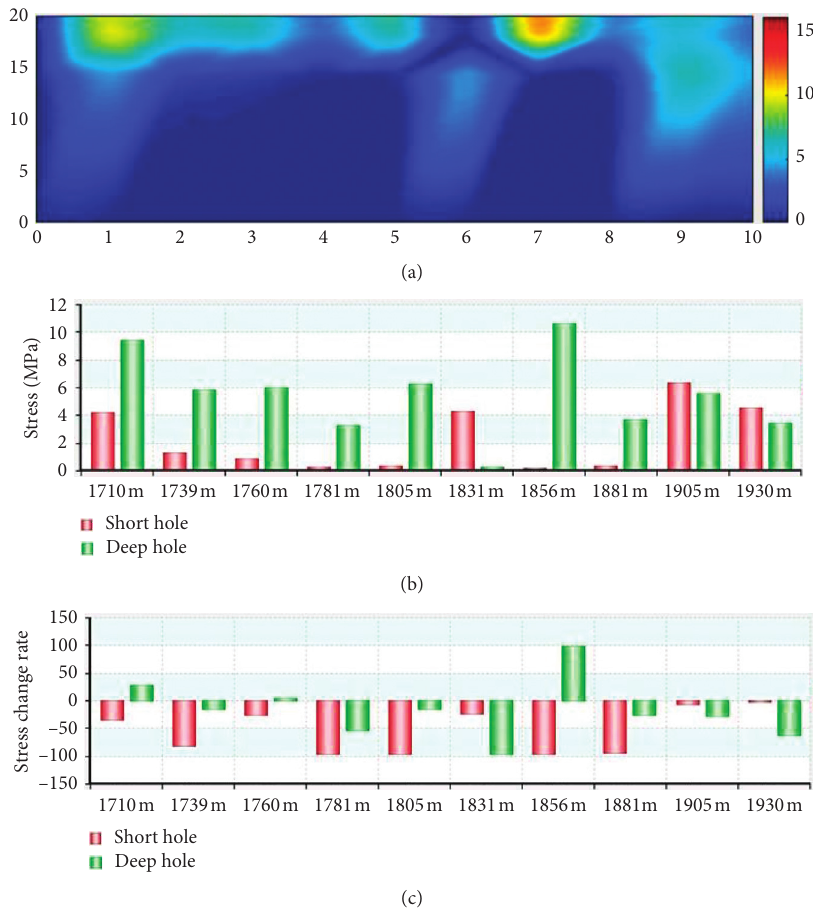
Figure 13: Stress monitoring results of No. 1411 working face without advancing pressure relief. (a) Stress nephogram of No. 1412 upper roadway in Huafeng coal mine. (b) Stress histogram of the typical observation stations. (c) Stress change rate of typical observation stations. is a good pressure relief effect in coal mass, and the pre- working face. The stress value is 10.65 MPa, and the change vention and control measures can effectively eliminate the rate is 99.39%, showing a yellow warning. Stress values of the rockburst accidents. other boreholes are lower than 10 MPa, indicating that there